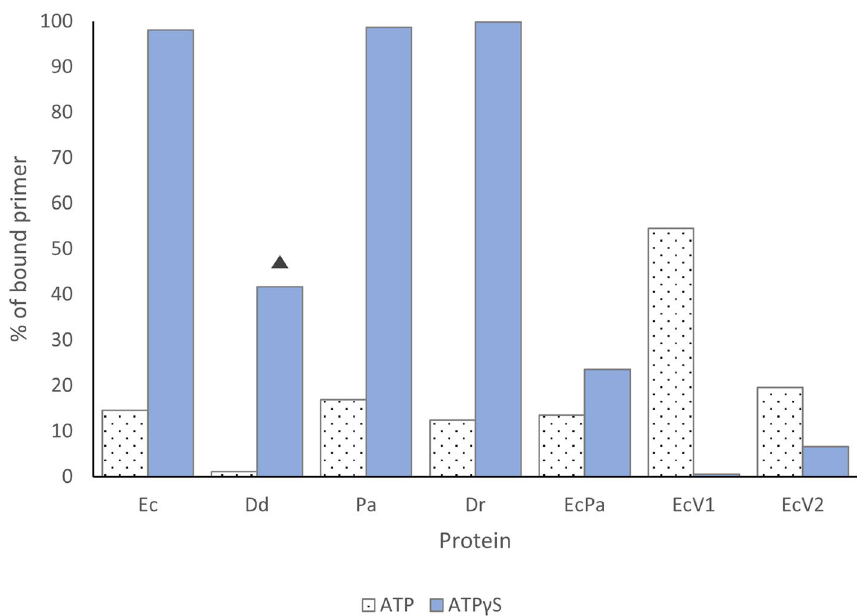
Figure 10. ssDNA binding by RecA variants in the presence of various cofactors. The histogram represents the percentage of fluorescence corresponding to the bound ssDNA compared to the total ssDNA fluorescence. ssDNA binding was assessed in the presence of ATP (white bars with black dots), which is expected to be hydrolysed by RecA and to generate ssDNA-RecA filament dissociation, and in the presence of ATPγS (blue bars), in the presence of which the filament is in a non-dissociating active configuration. The reaction was carried out for 10 min, except for DdRecA in the presence of ATPγS, for which the reaction lasted 20 min because the reaction was observed to be slower (results not shown) (this is indicated by filled triangle in the